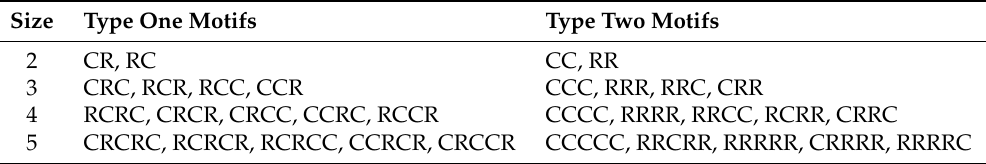
Table 2. Characteristic motifs of the higher (type one) and lower (type two) conflict subspaces across all 62 pages, ranked by partial-KL (see Ref. [43], Equation 2). The lower-conflict subspace is characterized by long runs of cooperation, but also by long runs of reversion. Conversely, the higher-conflict subspace is characterized by more rapid patterns of alternation between R and C